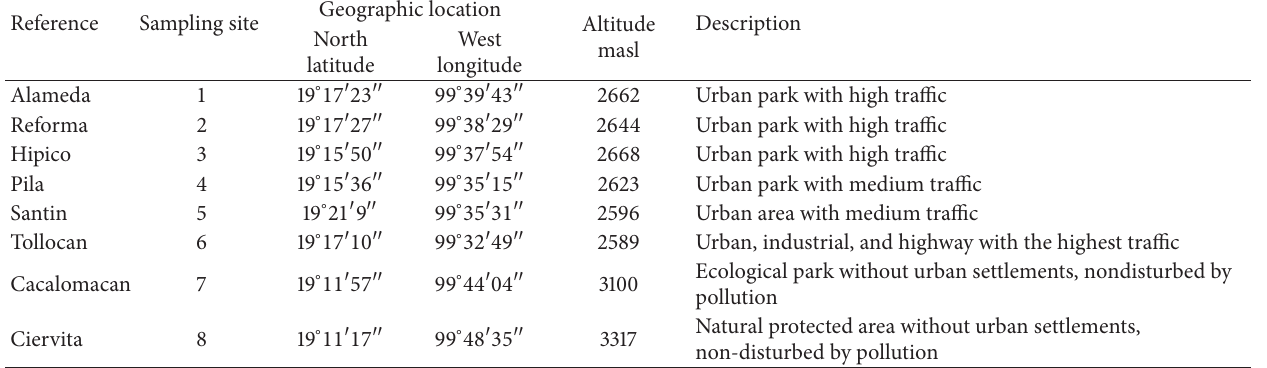
Table 1: Description of sampling locations at the Metropolitan Zone of the Toluca